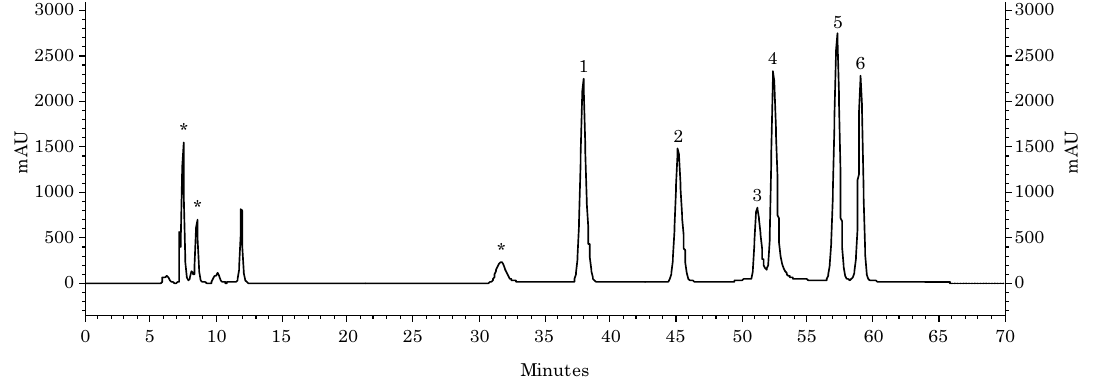
Figure 2. HPLC chromatogram of the working standard solution containing five monosaccharide standards, as recorded at 245 nm. Column: ODS Shimadzu C18 reverse phase (150 × 4.6 mm, S-5 μm). elution (0.5 ml min -1 ) performed using a gradient program of a combination of solvent a and solvent b containing 10-25 % acetonitrile in 0.1 mol l -1 ammonium acetate buffer (ph 5.5) for 70 min. (*) solvents and 1-phenyl-3-methyl-5-pyrazolone residue, (1) mannose, (2) rhamnose, (3) glucuronic acid, (4) galacturonic acid, (5) glucose, and (6) galactose.